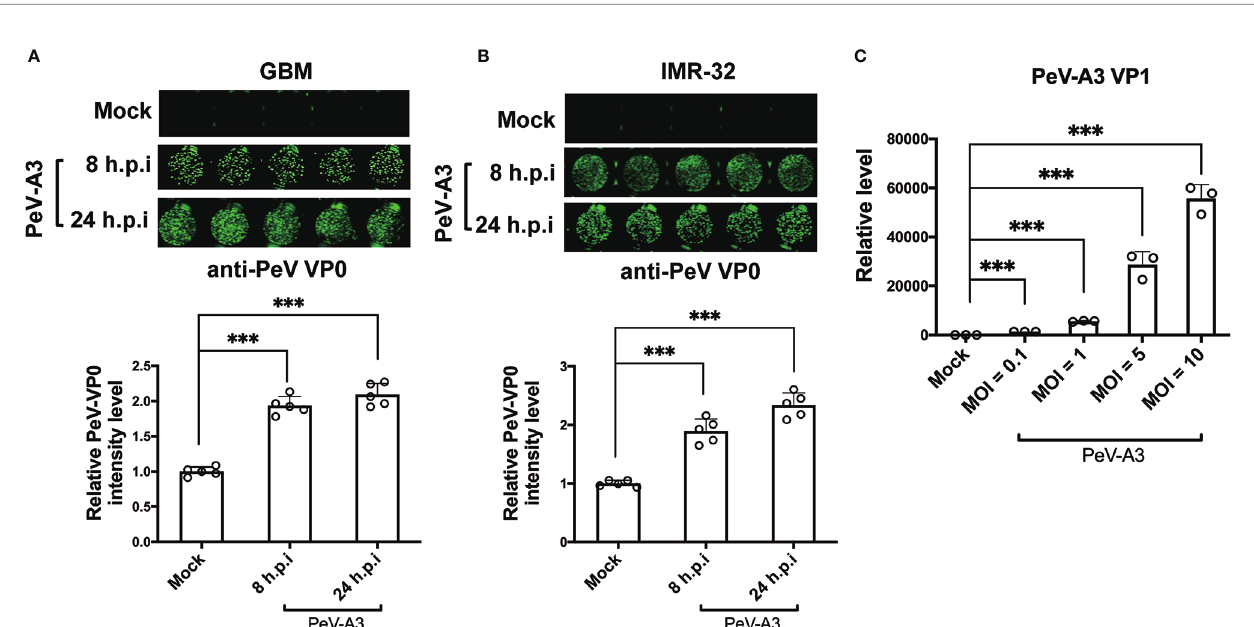
FIGURE 1 | Replication of PeV-A3 infection in GBM and IMR-32 cells. (A) GBM and (B) IMR-32 cells were infected with PeV-A3 at MOI = 5 for 8 and 24 h. Cells were then stained with anti-PeV AP0 antibody followed by IRDye ® 800CW goat anti-rabbit IgG secondary antibody. The cell images of immuno fl uorescent assay were captured (top panels) using Odyssey image system. Fluorescence intensities of PeV-A3-infected cells were quanti fi ed (bottom panels). Data are mean ± SD of fi ve independent experiments. Student ’ s t-test, *** p < 0.001. (C) RT-qPCR of PeV-A3 VP1 expression in GBM cells infected with PeV-A3 at MOI = 0.1, 1, 5, and 10 for 24 h. Data are mean ± SD. Student ’ s t-test, *** p < 0.001 compared with mock controls. PeV-A3, parechovirus type 3; GBM, glioblastoma; MOI, multiplicity of infection; VP1, viral protein